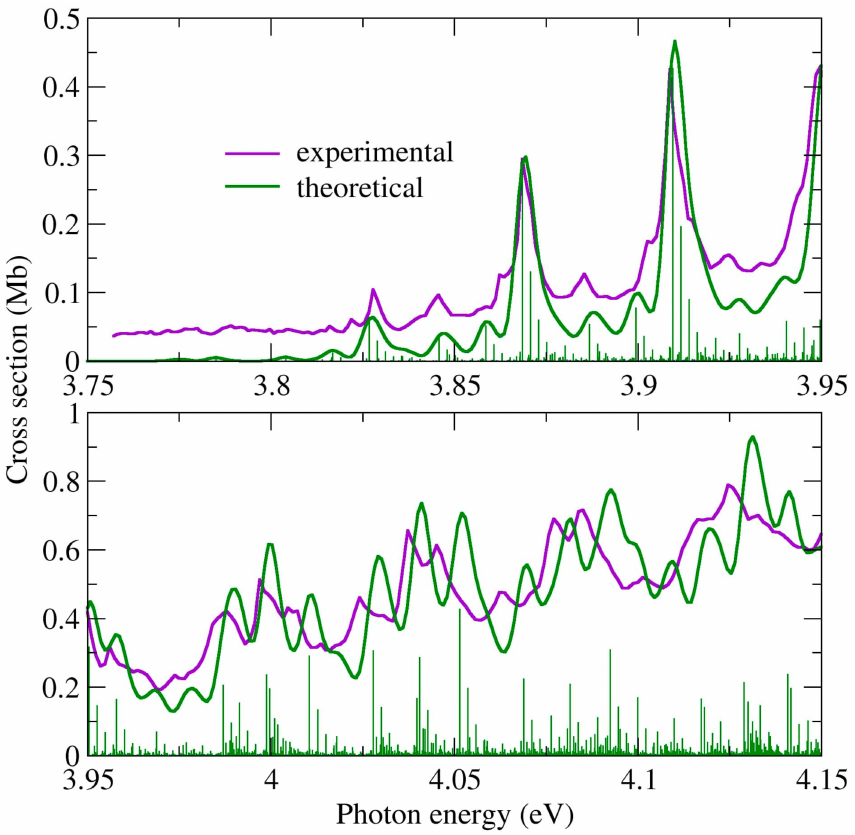
Figure 8. Comparison between measured and computed cross sections for the low energy tail of absorption Band I of